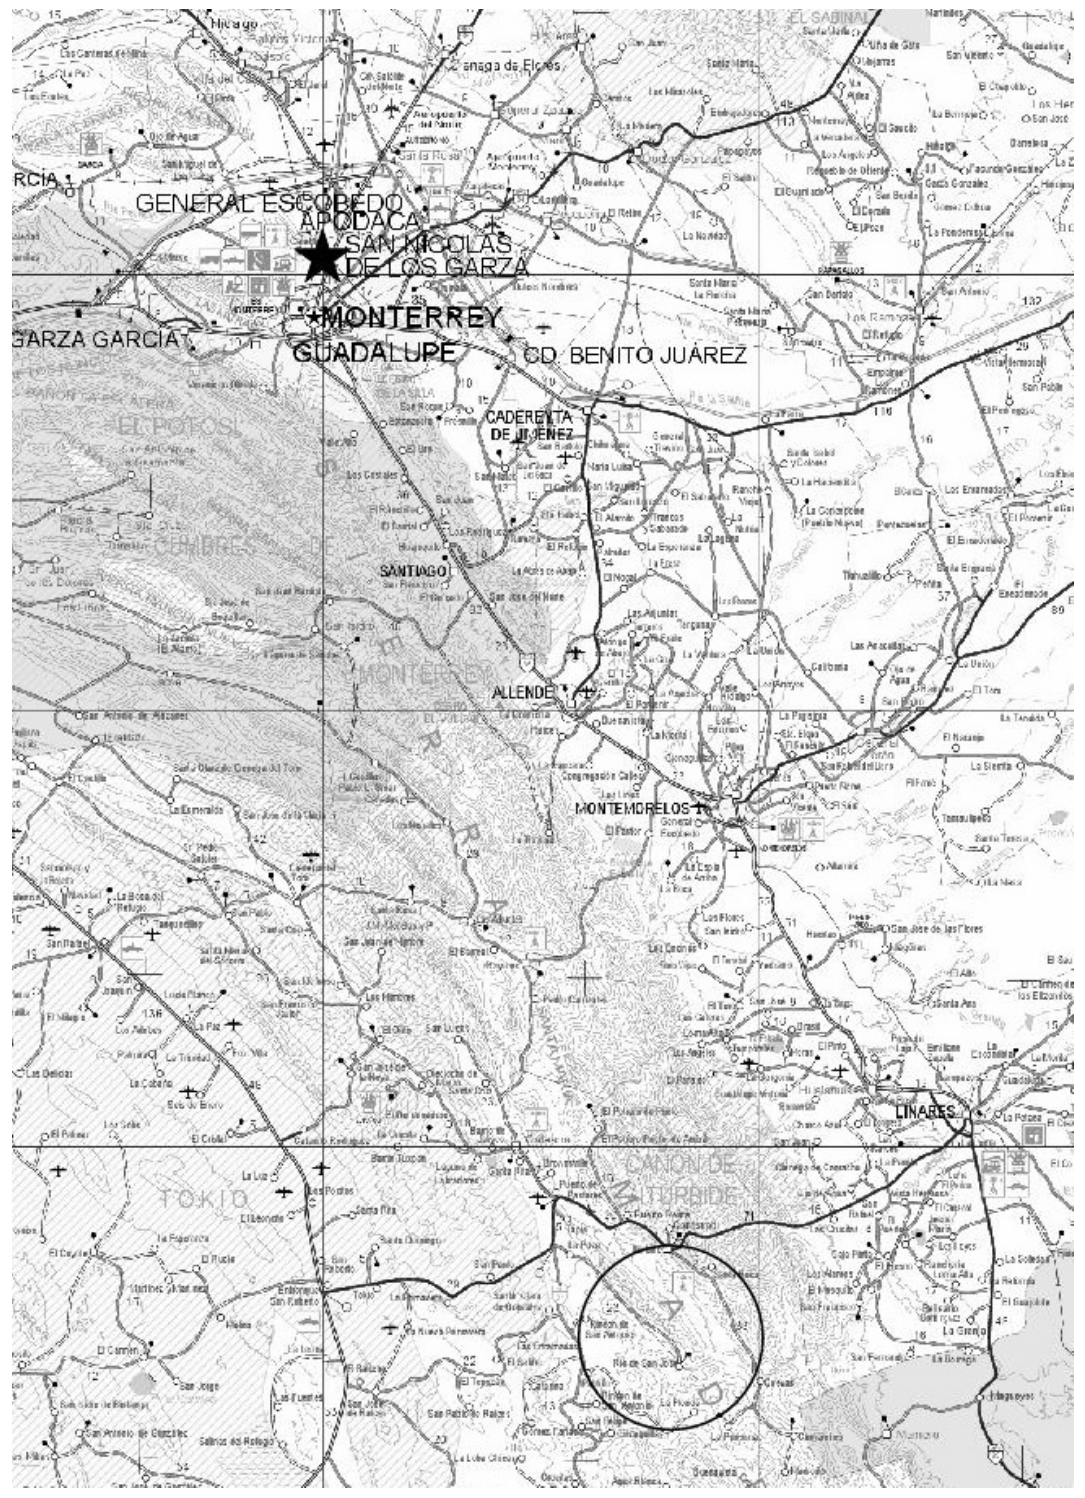
Figure 2. Shown the present ISON observatory position at Monterrey, marked by a star, and the prospect zone for its future southward movement, enclosed by a circle. One grid approx corresponds to 50